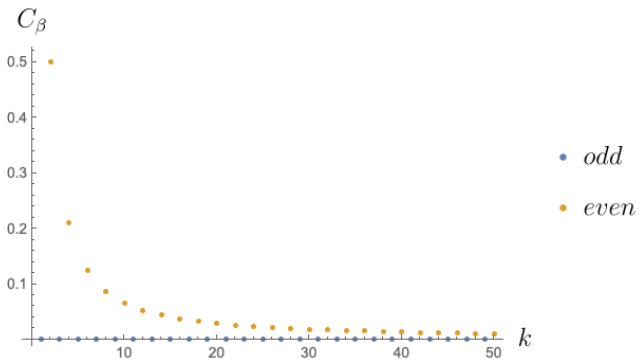
k WZW model (3.48). Note